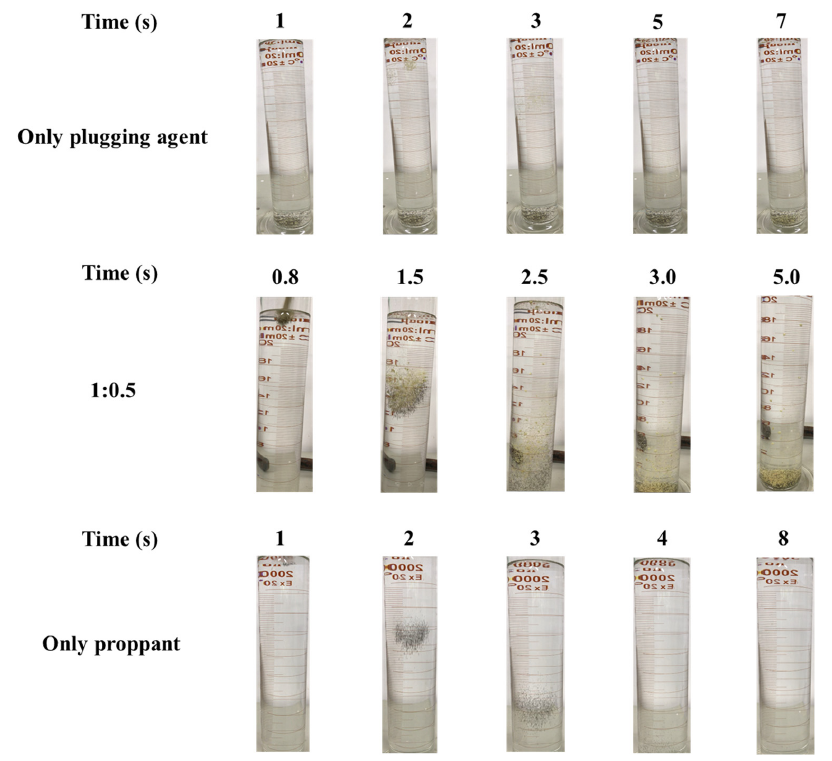
Figure 12. Settlement of the plugging agent and proppant (density = 2.00 g/cm 3 ) in water. Table 5. Sedimentation rates (cm/s) of the plugging agent and proppant (density = 1.15 g/cm 3 ) in water.